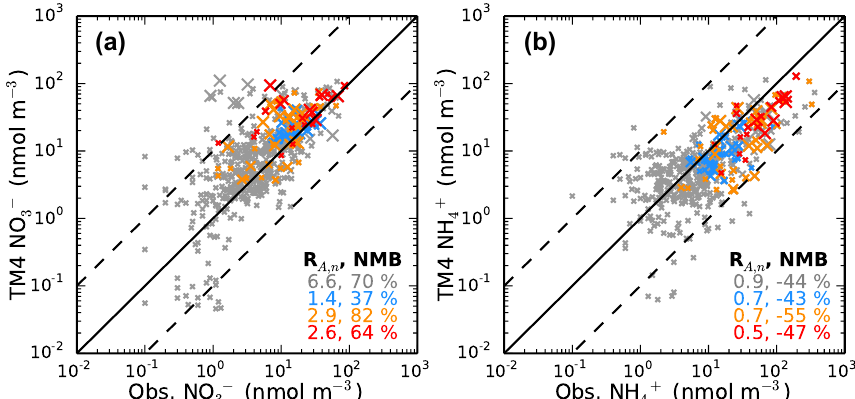
Figure 4. Scatter plots comparing mean 5 ◦ × 5 ◦ grid cell aerosol concentrations of (a) NO − with corresponding concentrations from the TM4 model. Data are plotted for each grid cell that contains observational data (grey), with cells from the TEAtl, NInd and NWPac regions coloured blue, orange and red, respectively. Marker size is proportional to number of observations in each cell, with the smallest marker representing 5 or fewer observations and the largest more than 15 observations. Solid lines indicate 1:1 observation–model relationship; dashed lines correspond to observation–model ratios of 10:1 and 1:10 in each panel. The weighted model–observation ratio ( R A,n ) and the normalised mean bias are given for each